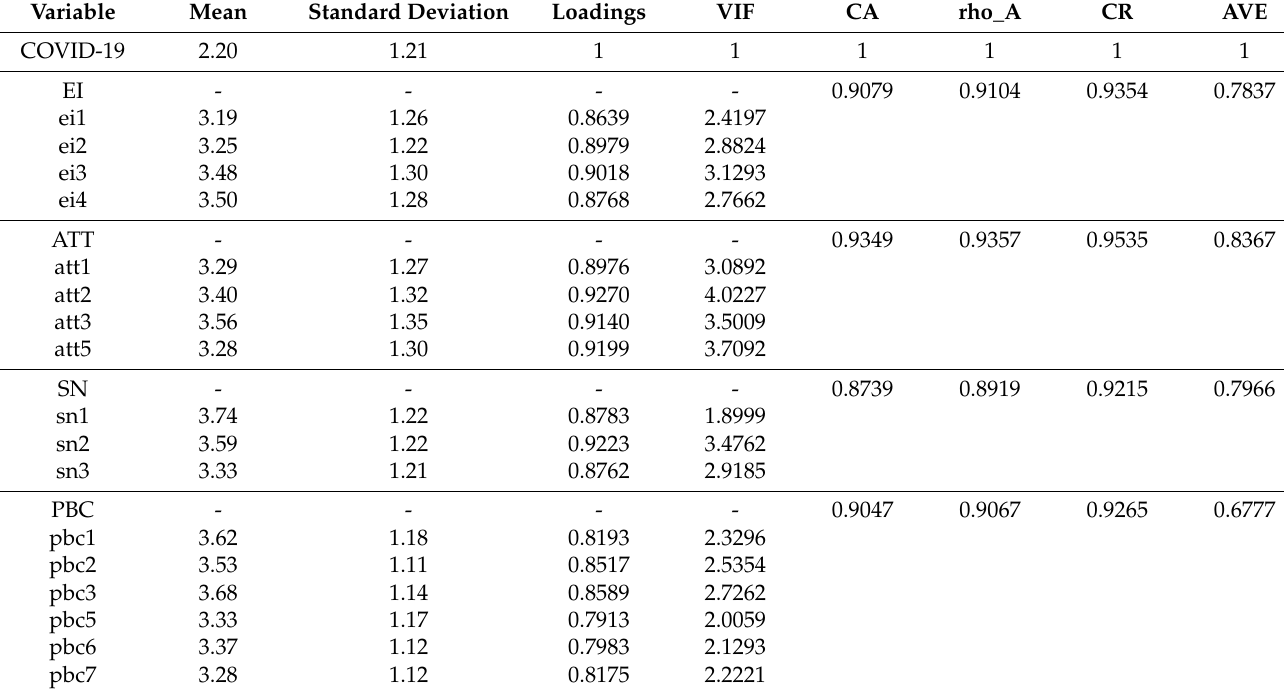
Table 2. Descriptive statistics and measurement model quality